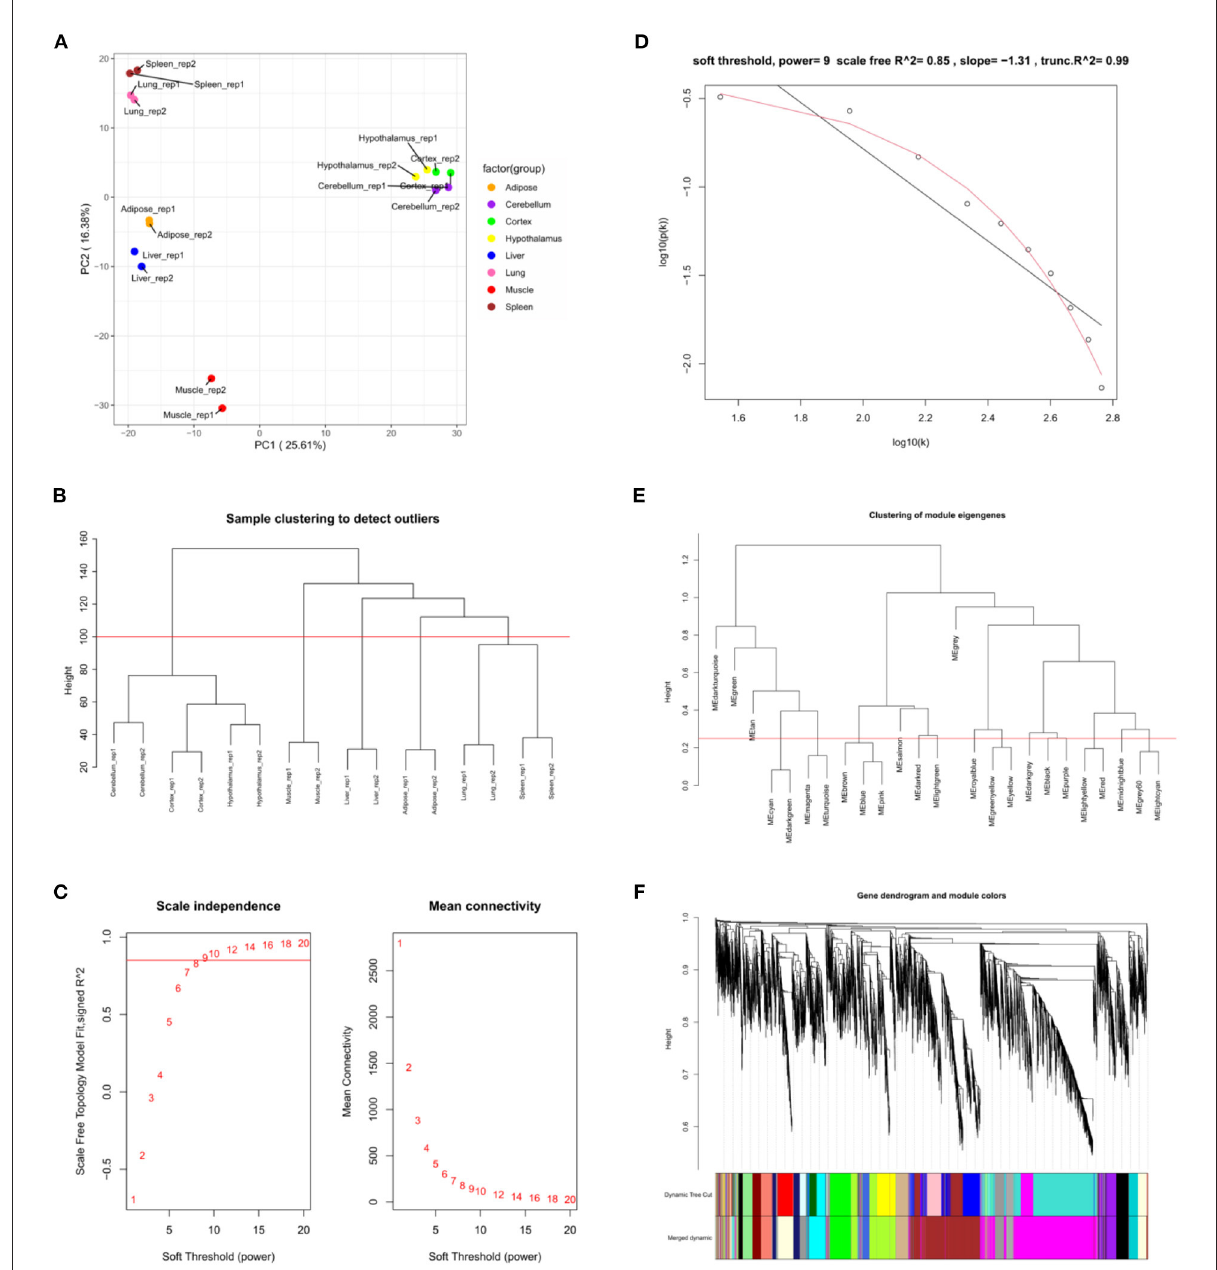
FIGURE2 Weighted co-expression network analysis. (A) Principal component analysis of all samples. (B) Sample clustering tree. The red line represents the outlier elimination reference line; (C) Soft-threshold powers ( β ) filtering analysis. The mean connectivity (y-axis) for various soft-threshold powers (x-axis) was showed on the left, and the mean connectivity (y-axis) of different soft-thresholding power (x-axis) was showed on the right; (D) Checking the scale-free topology when β = 9. X-axis: the log10 (network connectivity), y-axis: log10 (the corresponding frequency distribution). The distribution approximates a straight line, which is called the approximately scale-free topology; (E) The clusting of module eigengenes. The red line represents the reference line for similar module merging; (F) The cluster dendrogram of modules.